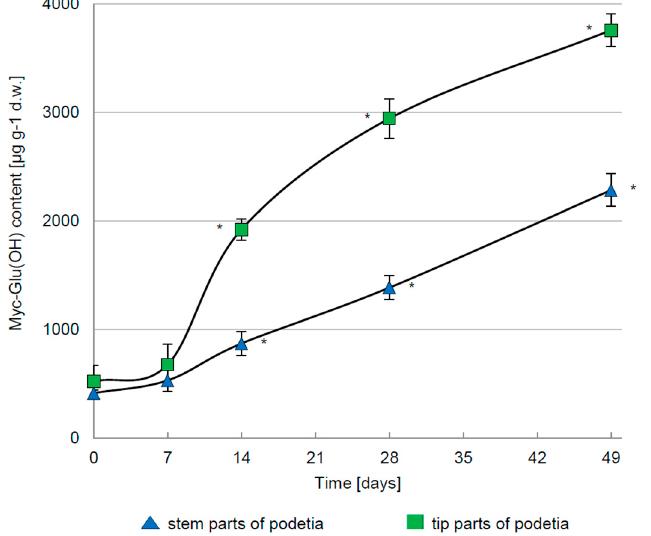
Figure 4. The concentration of Myc-Glu(OH) in C. arbuscula thalli exposed to UV-B irradiation at intensity of 5 µmol m − 2 s − 1 ; n = 5 ± S.D.; * p < 0.05, d.w.—dry weight.